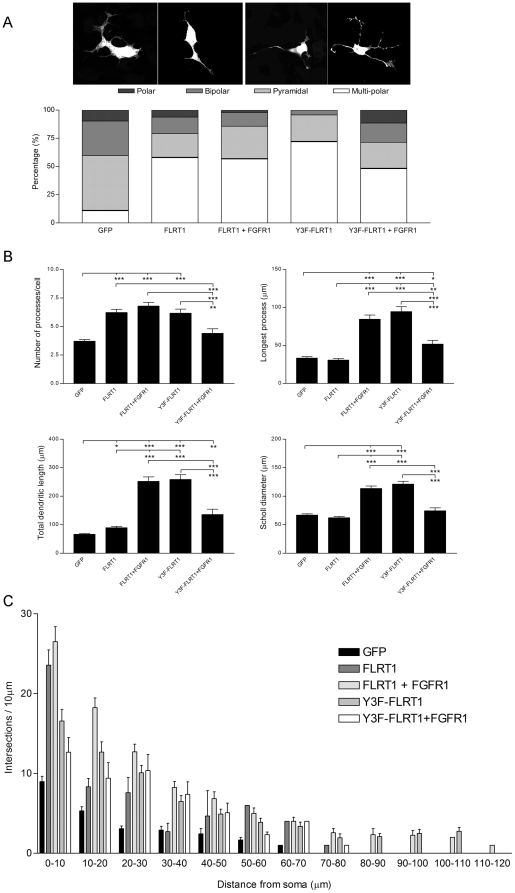
FLRT1 promotes neurite outgrowth in vitro.SH-SY5Y cells 48 hrs after transfection of either FLRT1-HA or Y3F-FLRT1-HA alone or co-transfected with FGFR1, as indicated, were stained for FLRT1 (using anti-HA) prior to morphological analysis A) Cells were assigned a ‘morphology’ based on the number of large diameter processes (>5mm in length) and cell shape as typified by the examples shown and B) several characteristic neuronal parameters were determined, such as number of processes, length of the longest process, total dendritic length and maximum cell diameter (Scholl diameter) Data in A) and B) was derived from •100 cells from at least 3 independent experiments C) the complexity of the dendritic arbour (Table S1) in a radial profile from the soma, was measured in a variation of the Scholl analysis (Sholl, 1953; see Figure S2) Data are represented as mean ± sem, n • 50 cells from at least 3 independent experiments Statistical significance in all instances used non-parametric Kruskal-Wallis and post hoc Dunns test (***p<0001, **p<001, *p<005) Images were acquired on a Leica confocal microscope and Image J was used to process stacked confocal sections to allow data determination.